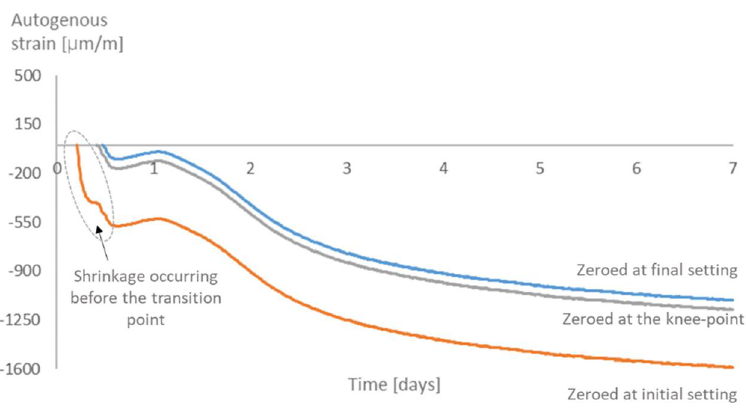
Figure 11. Autogenous strain for different time-zeros in REF0.3.